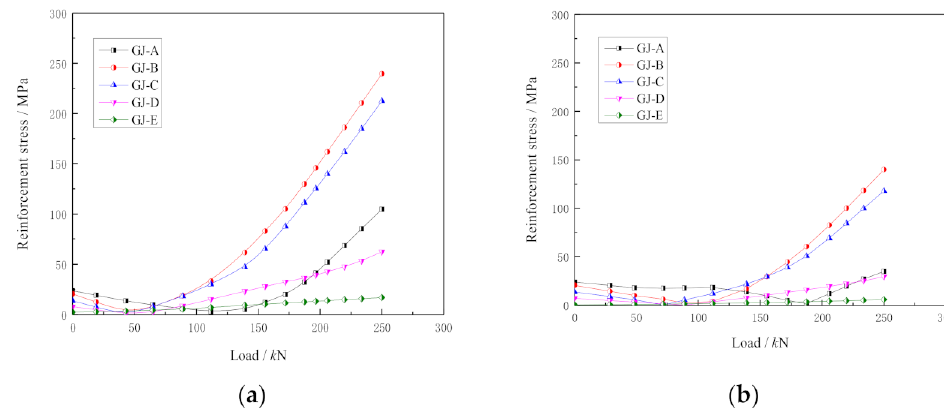
Figure 17. GD3 specimen: ( a ) No. 1 steel bar and ( b ) No. 2 steel bar.